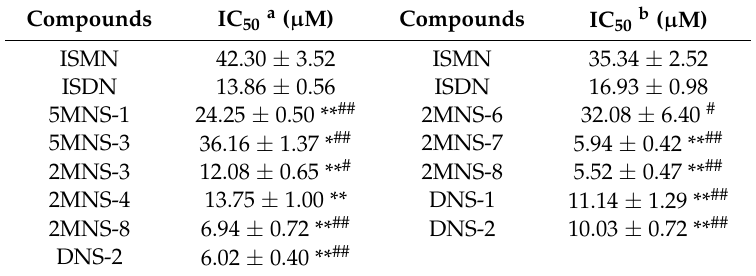
Table 2. IC 50 of nitrate derivatives on the contractions induced by phenylephrine or KCl in mesenteric artery